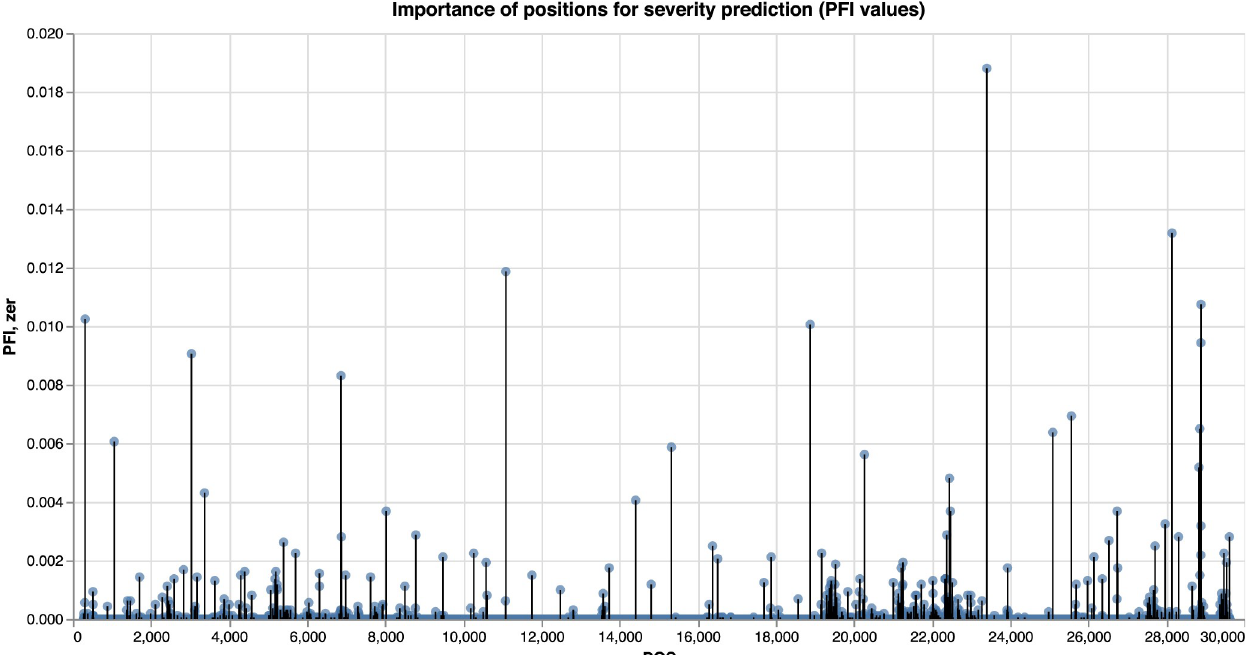
Fig 9. Feature importance analysis using PFI method. Manhattan plot. Feature importance based on the LGBM model, computed using the PFI method.